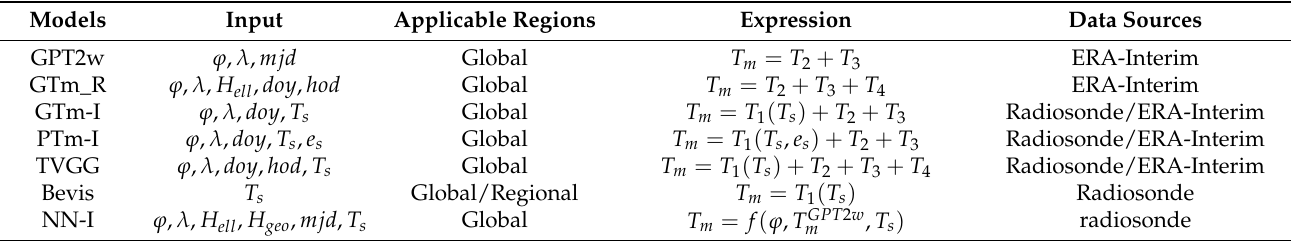
Table 1. Main differences between several representative T m models. GPT2w: Global Pressure and Temperature 2 wet; GTm: one-meteorological-factor model; PTm: multi-meteorological-factor model; TVGG: time-varying grid global model; NN-I: first-generation neural network-based T m